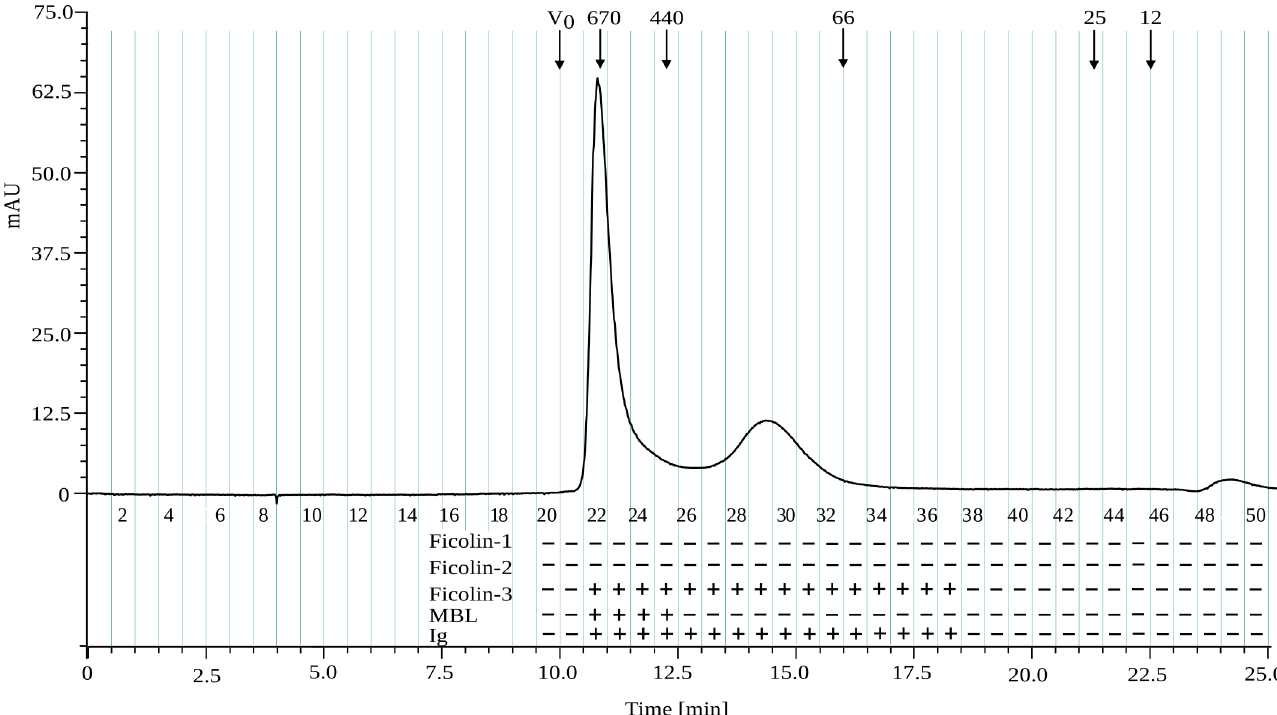
Fig 1. SEC-HPLC chromatography of plasma-derived ficolin-3 complexes on TSKgel G3000SW. Presence of ficolin-1, ficolin-2, ficolin-3, MBL and IgA, IgG, IgM (denoted “ Ig ” ) were detected by dot-blot analysis, where a positive result is indicated by “ + ” . The apparent molecular mass of thyroglobulin (670 kDa), ferritin (440 kDa), BSA (66 kDa), chymotrypsinogen A (25 kDa) and cytochrome C (12 kDa) was determined in a separate chromatographic run; V 0 , void volume. Even fraction numbers are indicated below the chromatograph line. Absorbance was monitored at 280 nm.